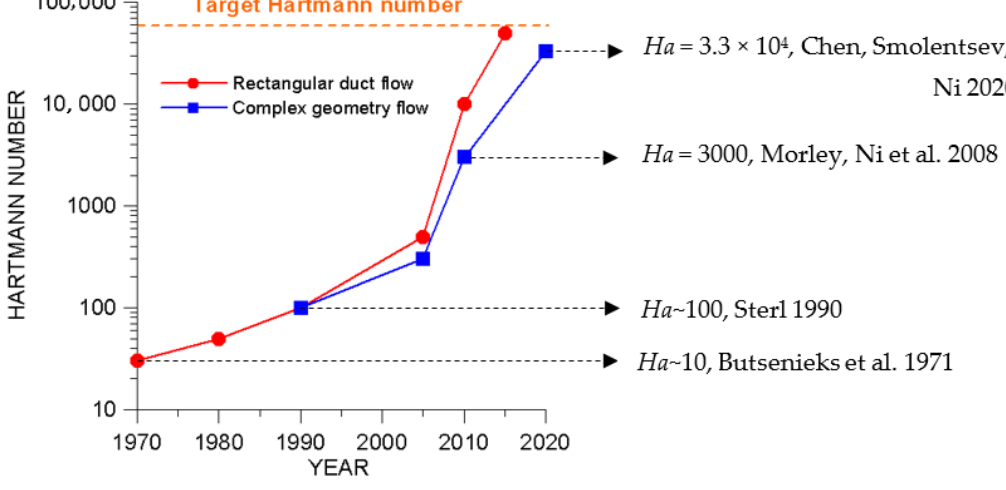
Figure 16. Progress in numerical computations of MHD flows.